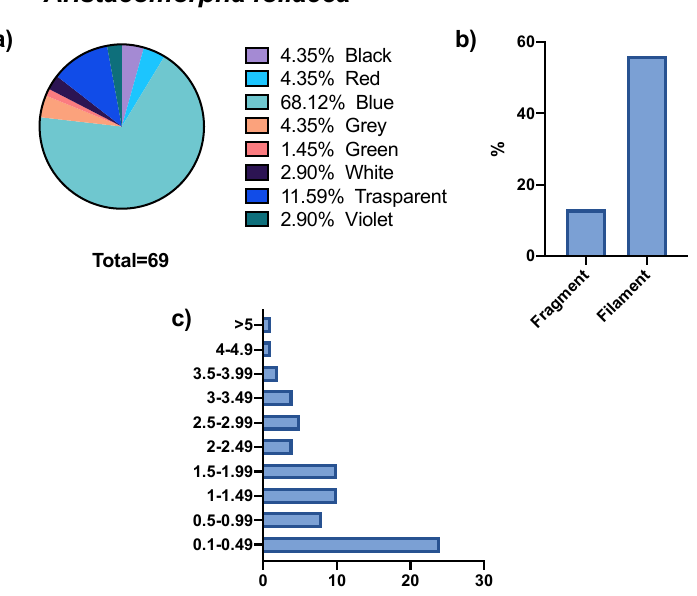
Figure 4. Abundance, colors ( a ), shape ( b ), and size ( c ) of microparticles isolated from A. foliacea.